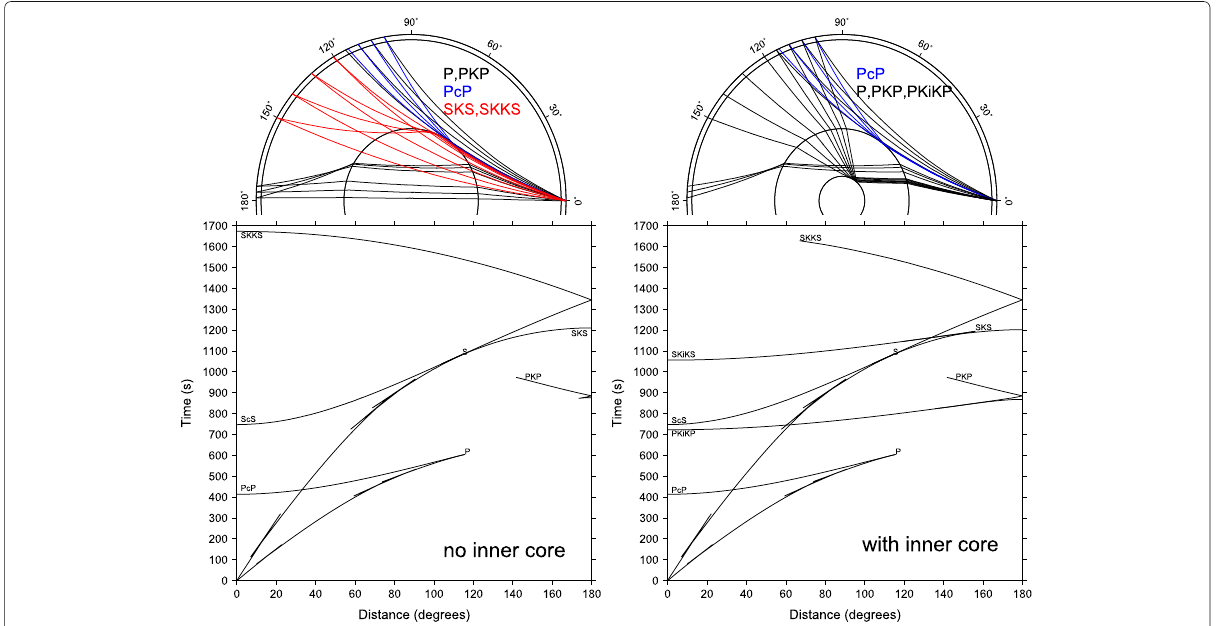
Fig. 7 Ray paths (top) and calculated travel times (bottom) in the Sohl and Spohn (1997) model A, with (right) and without (left) an inner core. The inner core’s properties are only scaled version of the Earth’s inner core and only meant to be indicative of the change in the travel time curves, and not otherwise physically justified. The horizontal axis is distance from an earthquake source at 0, measured in degrees of arc around the planet. The lag time until an arrival is seen is the time plotted on the vertical axis. Each type of seismic wave arrival traces a continuous path as a function of distance. Curves with positive slopes travel directly between the source and receiver (along the minor arc, to distances <180°). Curves with negative slopes travel the long way around the sphere (along the major arc to distances >180°). Each wave type is labeled with its name (see the “Appendix” section for nomenclature). The core’s low wavespeeds with respect to the mantle cause a P-wave arrival shadow, the gap between P and PKP between ∼ 120– ∼ 180 ◦ (top left). The main difference is that the inner core reflection PKiKP (and PKIKP) illuminates the shadow region when an inner core is present (top right). SKS and SKKS illuminate the core, but the ranges of the SKS (>160°) and SKKS (>300°) arrivals are truncated by the presence of an inner